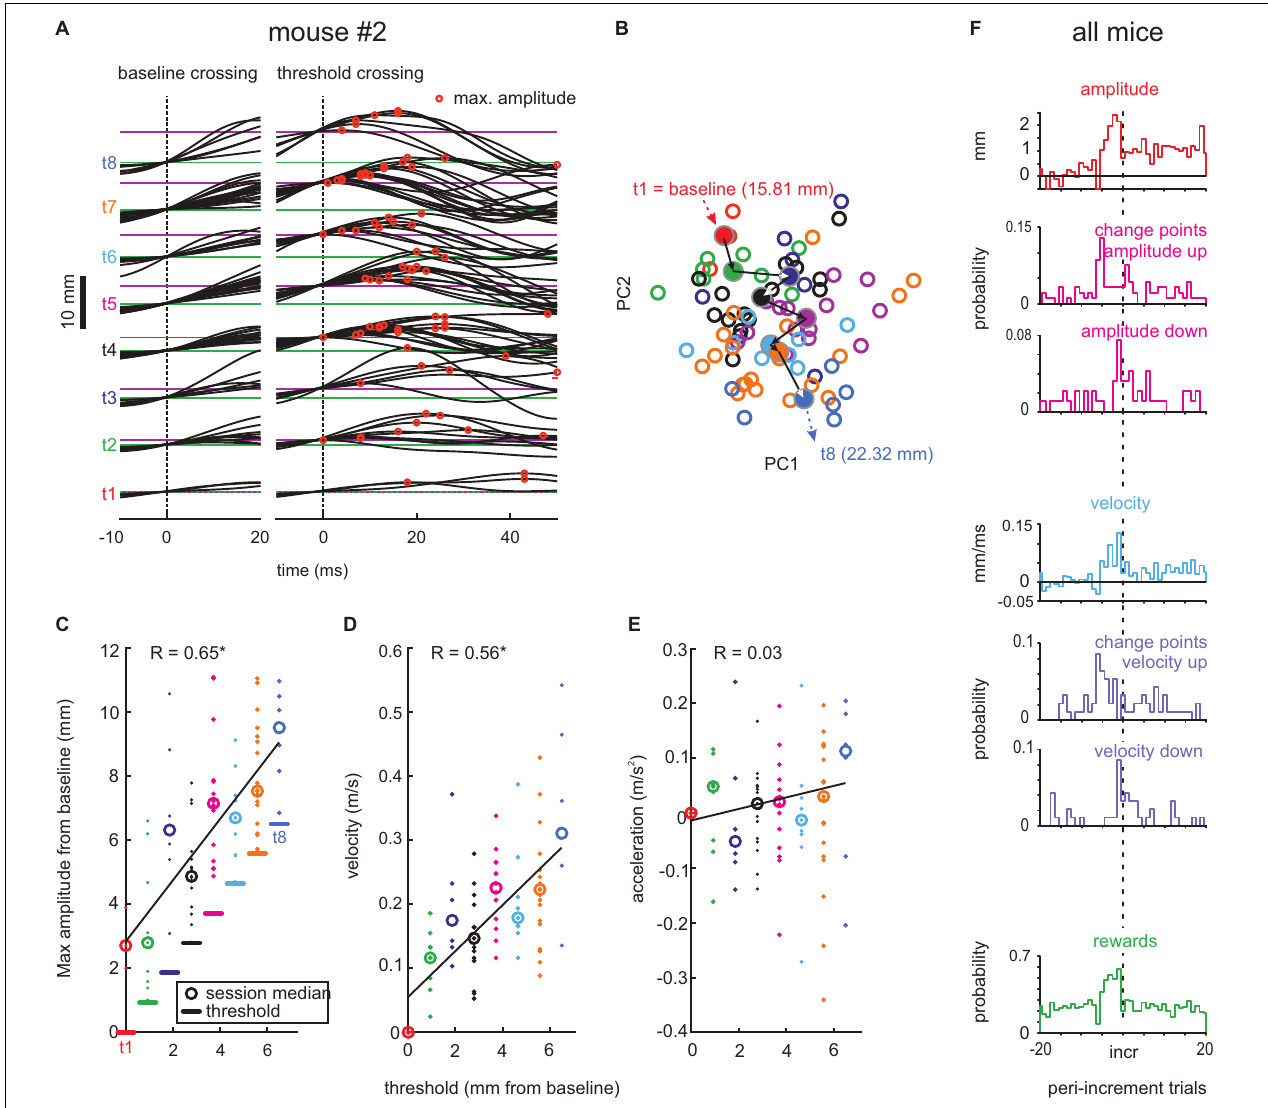
FIGURE 2 | Adaptive whisking. (A) Example session. Whisker trajectories triggered by baseline crossing (green, left) and threshold crossings (magenta, right). Eight threshold levels (t1–t8) were reached in this session. Red circles mark maximum whisker position. (B) Plot of coefficient of first and second principal components (PC1 and PC2) of waveforms generated with each threshold (colors match those in the other panels). Circles: single trials. Dots : Center of mass for each threshold. Arrows : Mean trajectory across the 8 thresholds. Thresholds in mm, as given here, translate to degrees as follows [ 2 , 4 , 6 ] mm ˆ= [ 22 , 39 , 50 ] deg. (C) Amplitudes reached with each threshold. Linear regression in black. (D) Same as in panel (C) for maximum whisker velocity. (E) Same for maximum acceleration. (F) Population data. Histograms of maximal amplitude (red), maximal velocity (blue), and rewards (green) on the peri-increment trials (zero is the increment trial; bin size = 1 trial). Histograms of change points taken from the trial series of maximal amplitude (magenta) and maximal velocity (violet). All change points exceeding the confidence level of 0.7 are shown. Maximal amplitude and velocity (red and blue histograms) are plotted relative to the mean value observed in trials -20 to -10 (indicated by zero) to emphasize the dynamics of these kinematic parameters around the increment